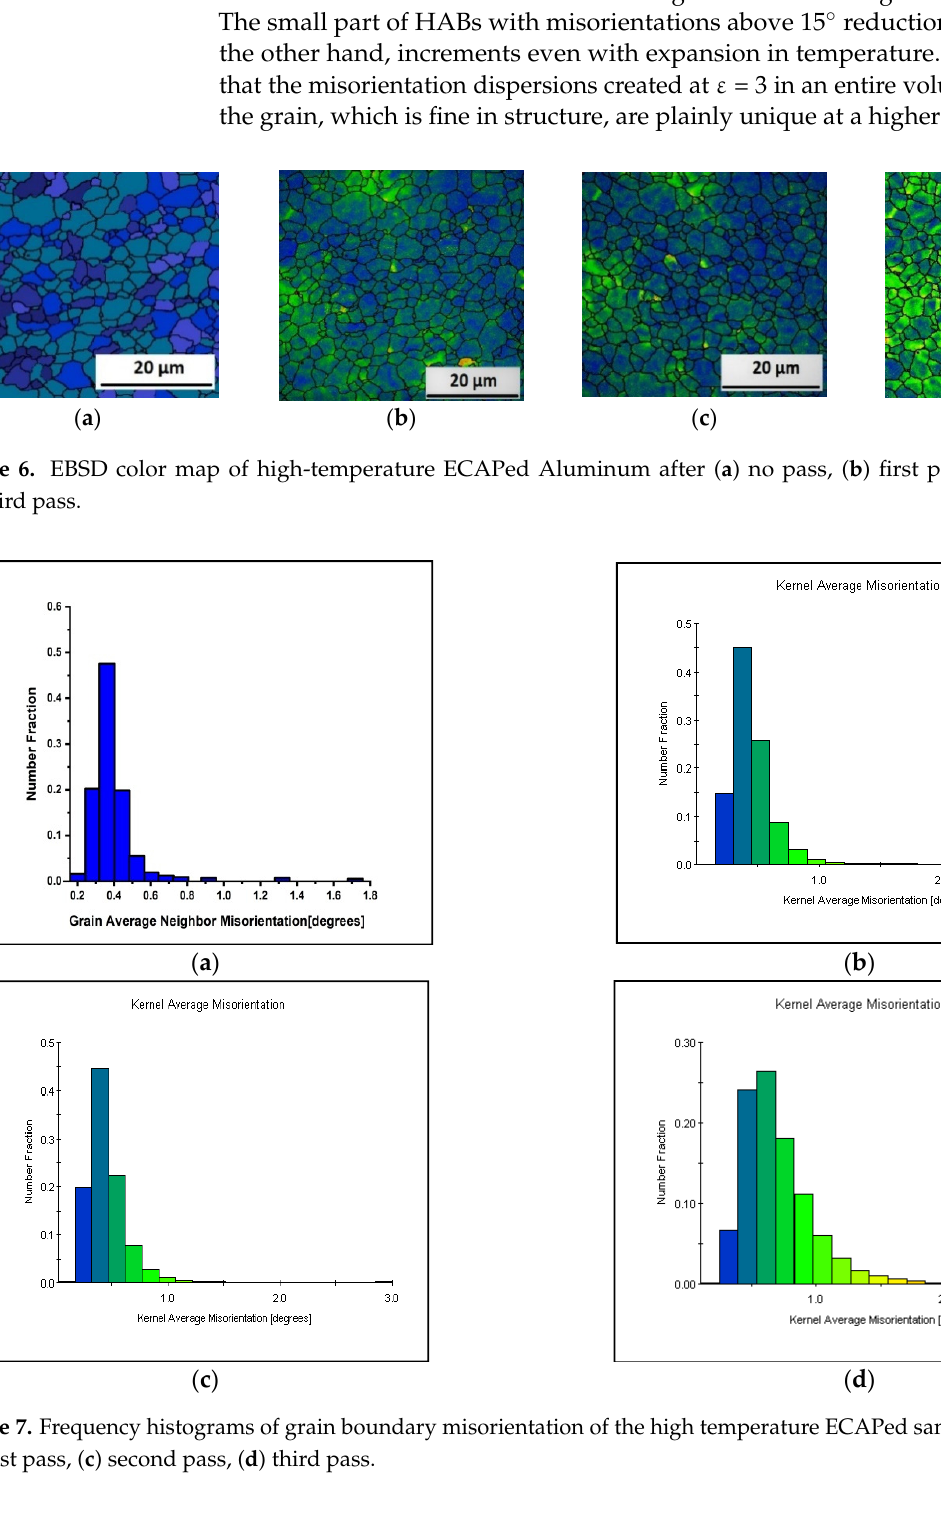
Figure 5. Frequency histograms of grain boundary misorientation of the ECAPed sample after ( a ) no pass, ( b ) first pass, ( c ) second pass, ( d ) third pass at ambient temperature.